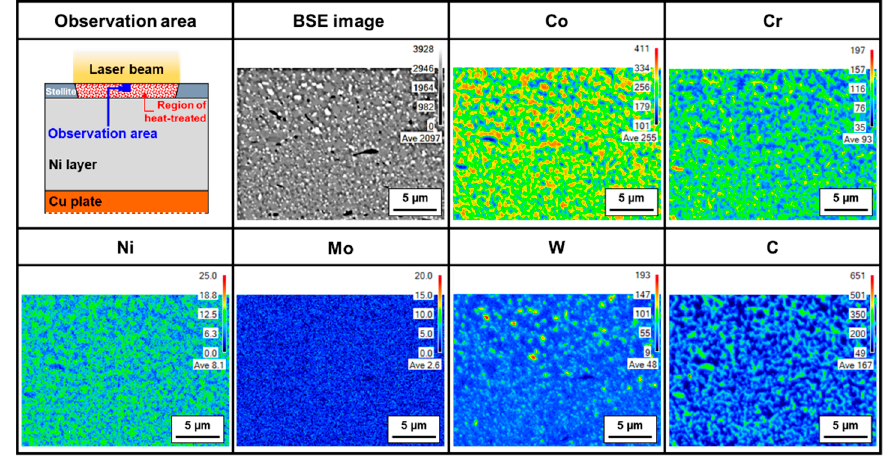
Figure 10. Element distribution and BSE images of the Stellite-1 coating after laser heat treatment at 1473 K.